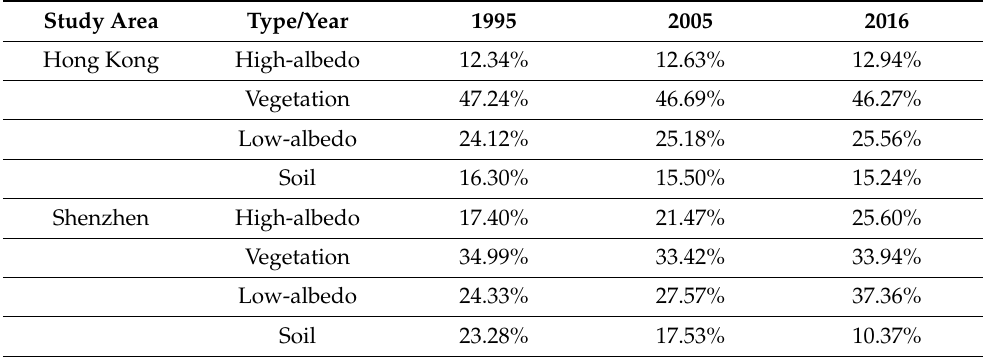
Table 3. The proportion of high-albedo, low-albedo, soil, and vegetation of Hong Kong and Shenzhen in 1995, 2005, and